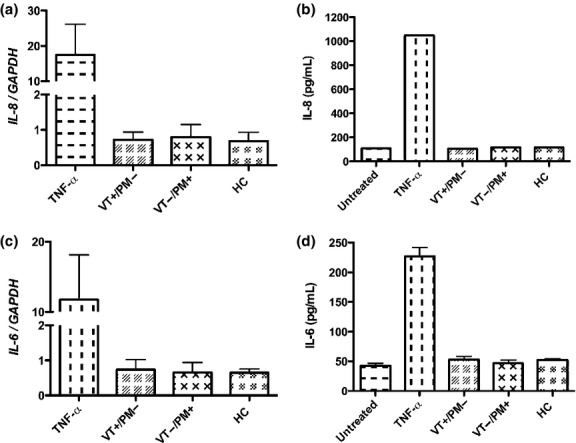
APS-IgG do not increase the transcript or protein secretion of the cytokines IL-8 and IL-6 in HTR-8 cells. HTR-8 cells were treated with 100 μg/mL pooled IgG from VT+/PM− with 83.7 GPLU and 66.0SU binding activity, VT−/PM+ with 47.2GPLU and 63.8SU binding activity and HCs with 0GPLU and SU binding as well as the positive controls TNF-α (10 ng/mL). Graphs (a–d) show qRT-PCR analysis of IL-8 (a), and IL-6 (c) mRNA expression at 6 hr and ELISA results of IL-8 (b) and IL-6 (d) protein expression at 72 hr. The mean ± SEM of quantitative analysis from four independent experiments is shown. No statistically significant differences were found by one-way anova.